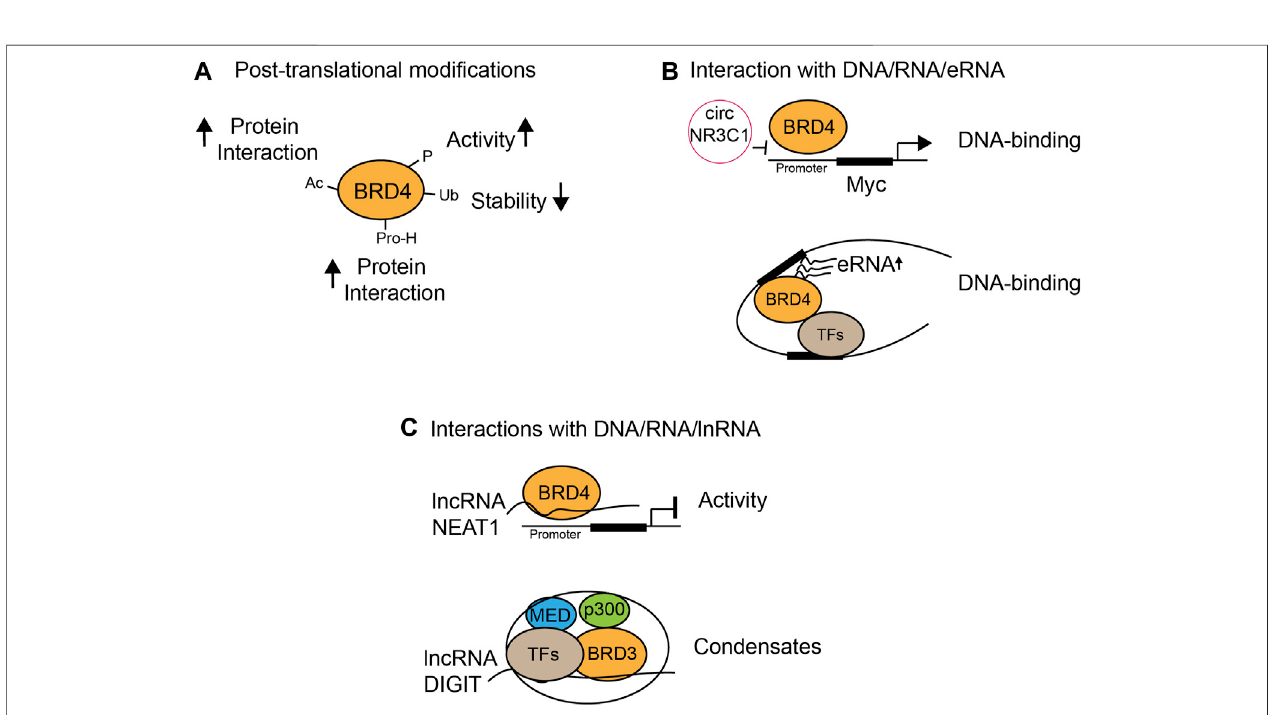
FIGURE 3 | Functional modulation of BET proteins by chemical modi fi cations and protein or nucleic acid interactions. (A) Protein stability and activity by post- translational modi fi cations such as acetylation (Ac), phosphorylation (P), ubiquitination (Ub), and proline-hydroxylation (Pro-H); (B) modulation of DNA binding through interactions with circular RNA (circRNA) and enhancer RNA (eRNA); (C) BRD4 transcriptional activity and condensate formation through interactions with long non- coding RNA